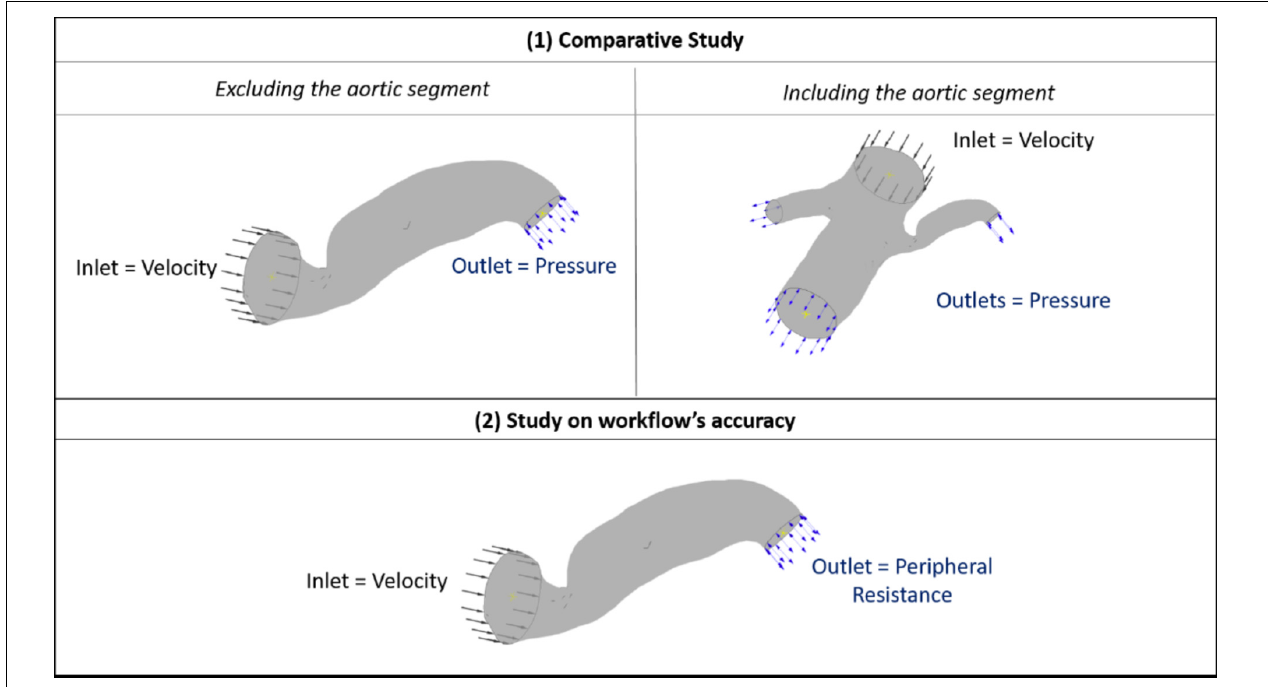
FIGURE 3 | Boundary flow conditions for the set of simulations. The image summarizes the boundary flow conditions applied on the computational simulations: (1) for the comparative study between including and excluding the aortic segment (top row) and (2) for testing the accuracy of the workflow (bottom row) across the patient data set. The case of Patient 7 is used here for illustration purposes.